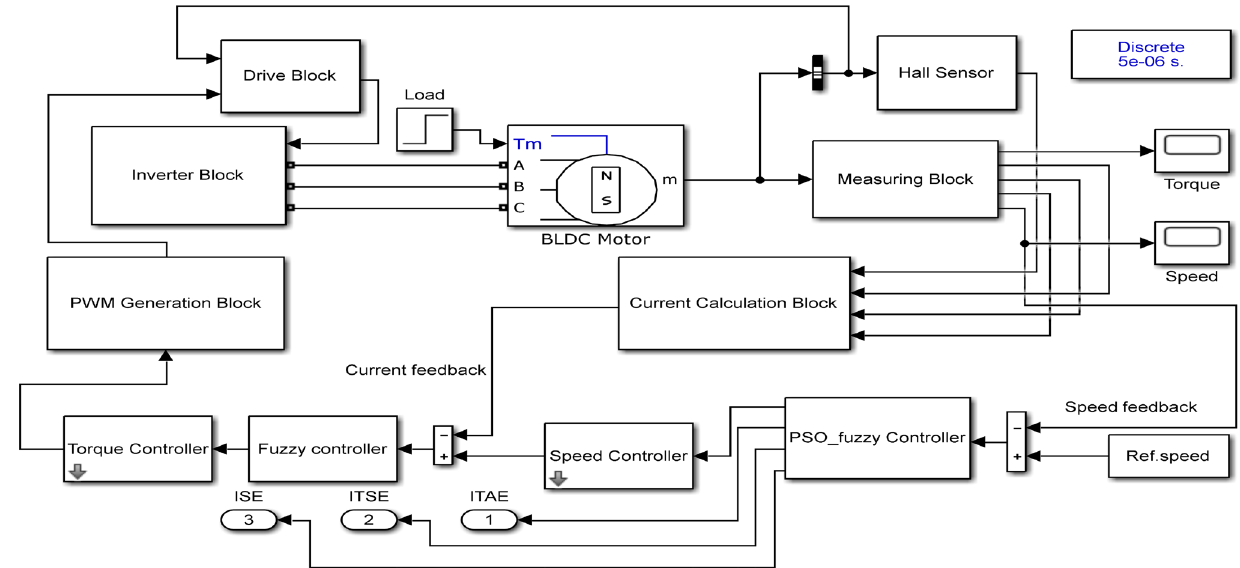
Fig. 7 BLDC motor simulation model of PF-PI structure controller